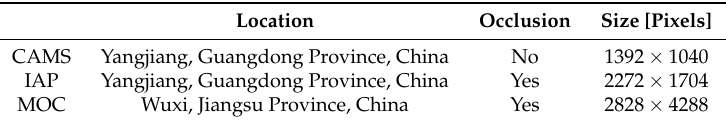
Table 2. The differences of three cloud databases.